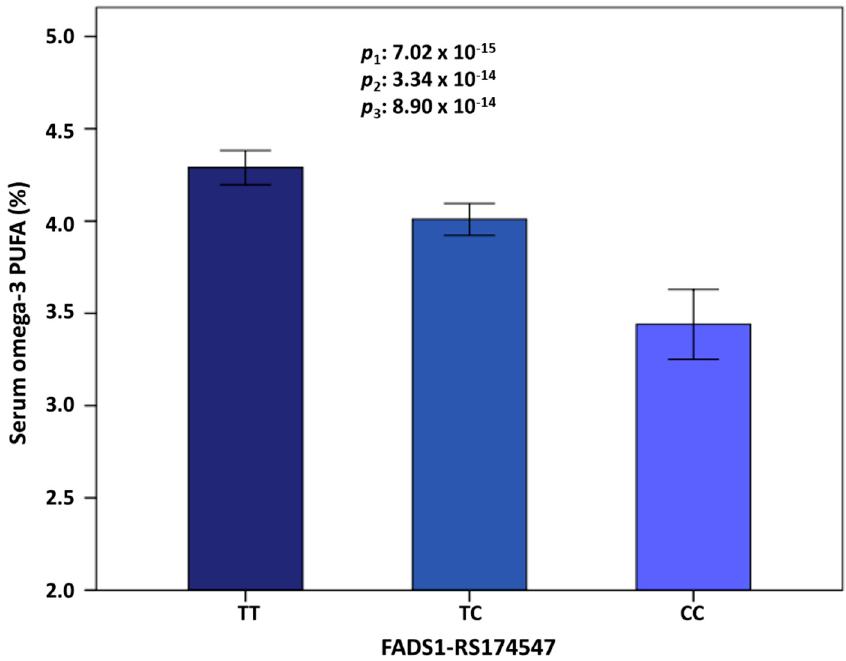
Figure 4. Serum omega-3 PUFA concentrations (%) depending on the FADS1 -rs174547 genotype in the whole population. Genotype prevalence was: TT 49.3% (n = 212), TC 41.0% (n = 172), and CC 9.7% (n = 42). The minor allele (C) was associated with lower concentrations in all the adjusted models. 1: Unadjusted model; 2: Model adjusted for sex, age, and diabetes; 3: Model adjusted for sex, age, diabetes, body mass index, medications (antihypertensive, hypolipidemic, and antidiabetic drugs), smoking, physical activity, and adherence to Mediterranean diet. Values are means by genotype. Error bars: 2 × Standard Error.